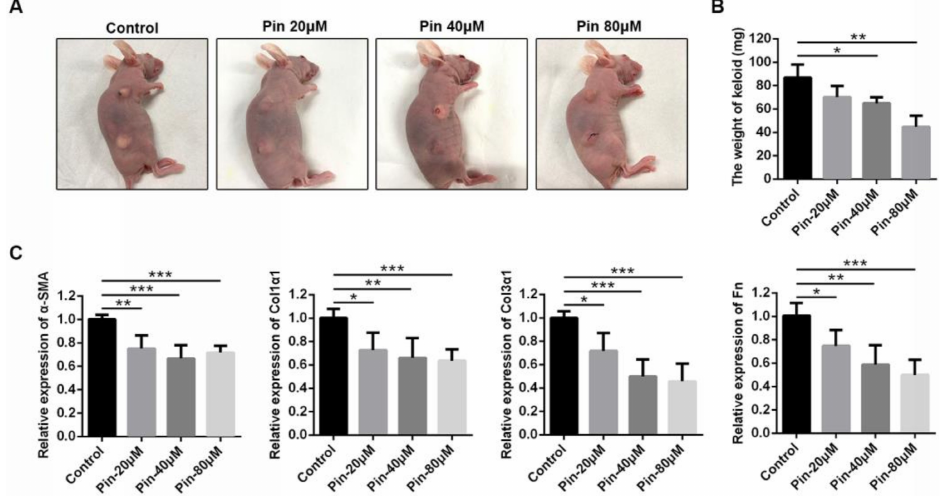
Figure 6. Pinocembrin accelerates the regression of xenografted keloid tissues and reduces ECM gene expression. ( A ) Macrographic examination of xenografted tissues on the back of nude BALB/c mice. ( B ) Weight of xenografted tissues after intralesional injection of pinocembrin. ( C ) mRNA levels of α -SMA, Col1 α 1, Col3 α 1, and Fn in xenografted keloid tissues were assessed by qPCR. Means ± SD, n = 4. * p < 0.05, ** p < 0.01, *** p <